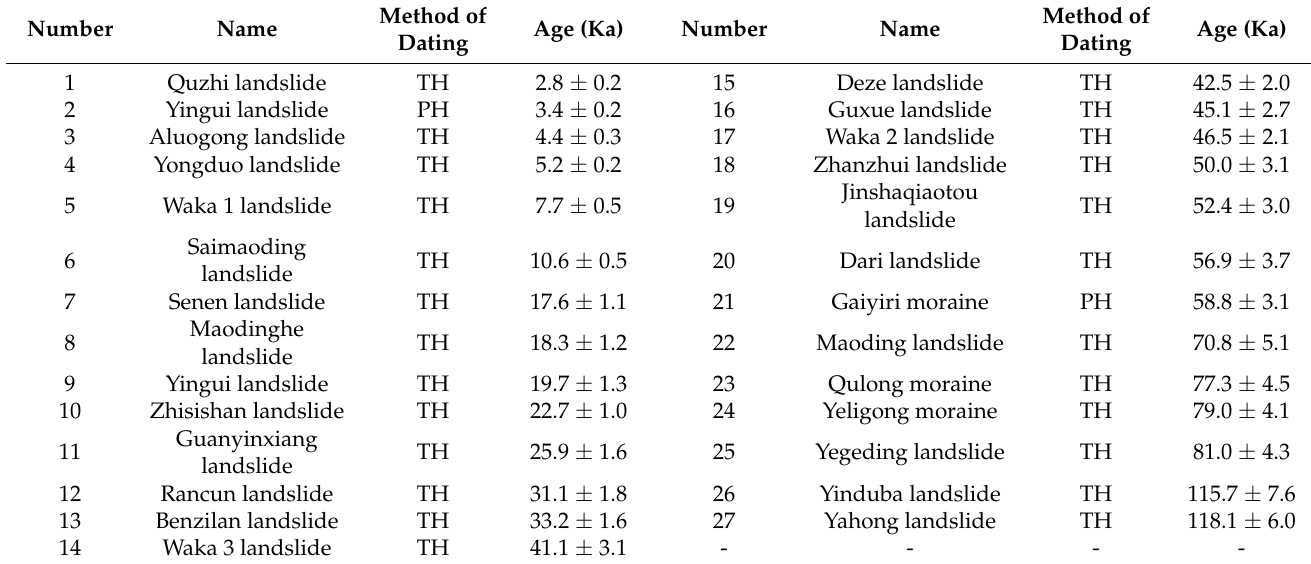
Table 7. Luminescence dating statistics of the landslides in the study area (sorted by age).